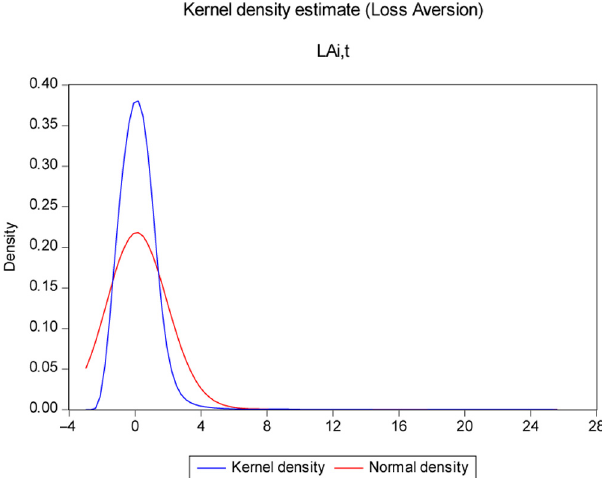
Figure 2. Non-normality of